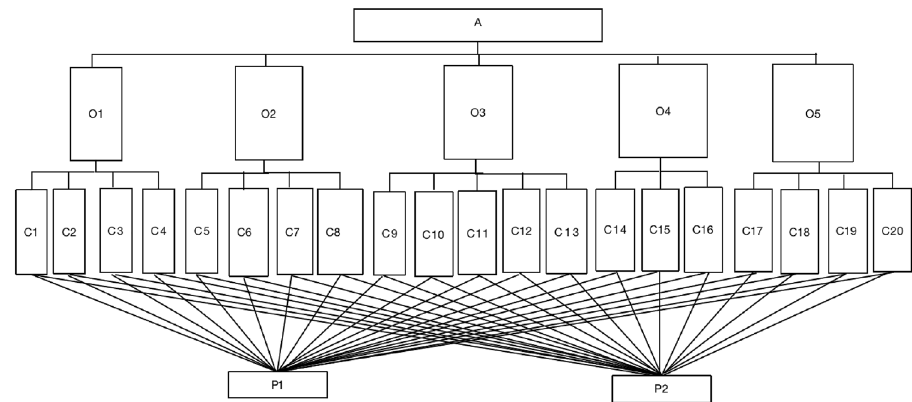
Fig. 1 Hierarchical model for decision analysis of waste